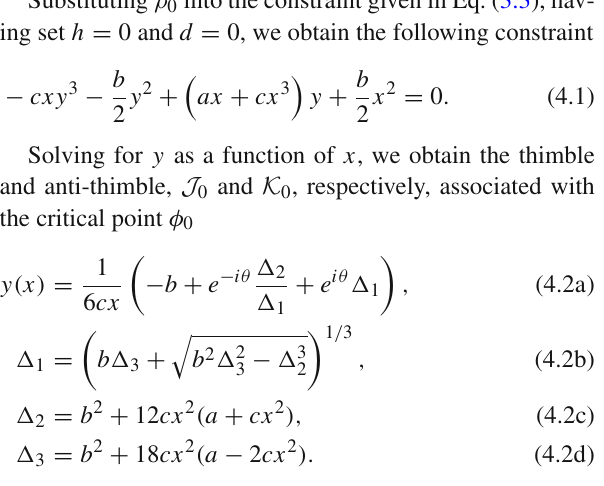
(c) Thimbles and anti-thimbles for the critical points φ ± of the action. curves represent the thimbles, red dashed curves represent the anti- thimbles, and the grey solid curves represent the ghosts. The shaded regions represent the regions where Re ( S ) ≥